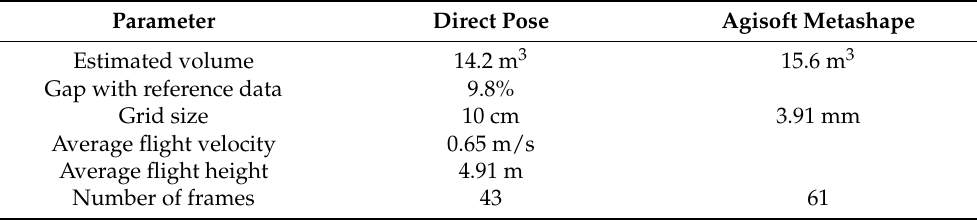
Table 3. Construction site experiment, quantitative